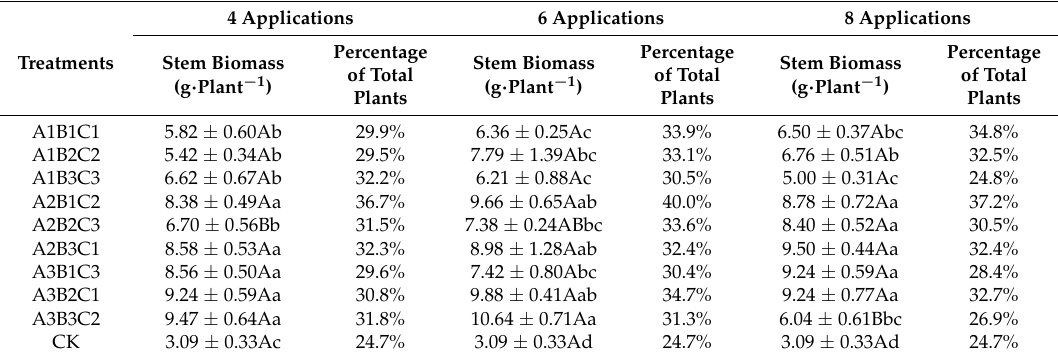
Table 8. Effects of different fertilization ratios and frequencies on stem